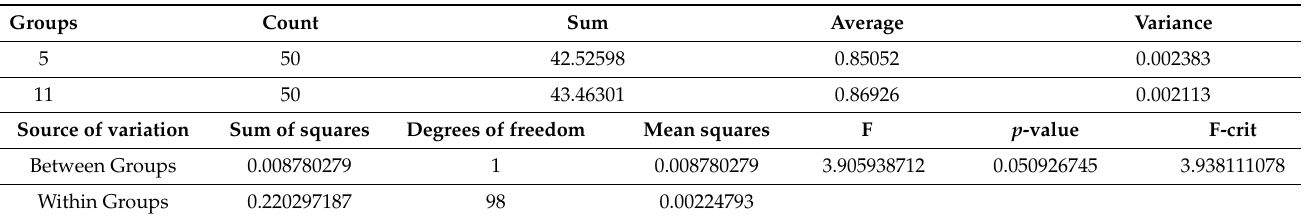
Table 5. ANOVA analysis of the model accuracy for models trained with 5 and 11 cultivation data for the incubation stage.